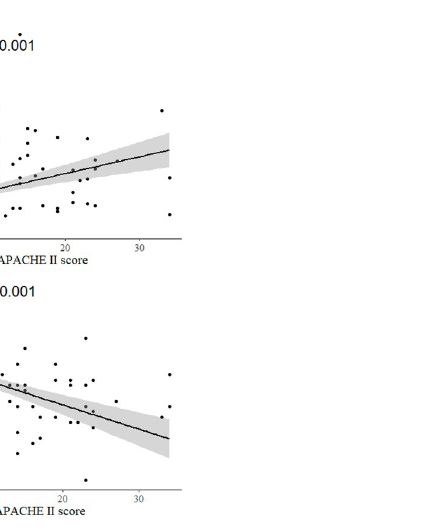
Fig 2. Correlations between APACHE II score and Age, RDW, BUN, and